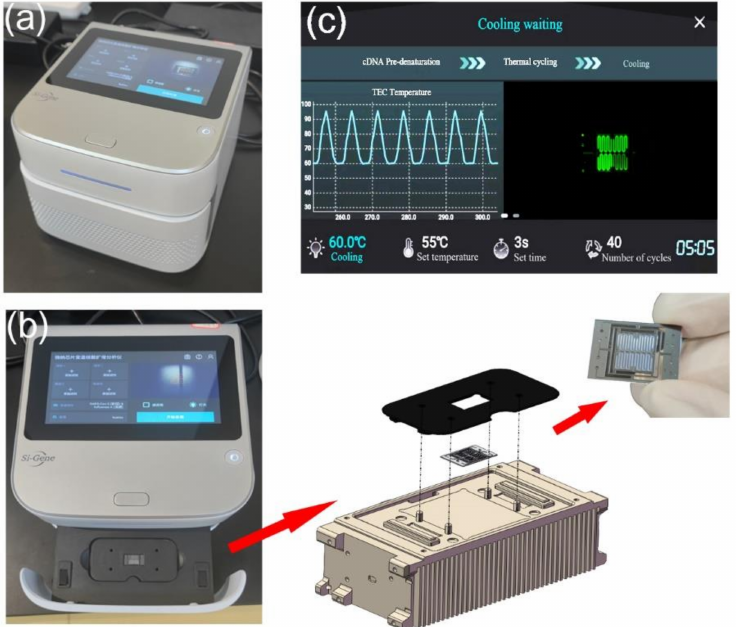
Figure 3. ( a ) Integrated ultrafast PCR detection equipment. ( b ) Slide mechanism for replacing the microfluidic chip. The miniaturized microfluidic chip is fixed on the thermocycling module through a holder. There are four positioning columns on the thermocycling module, which can precisely limit the position of the holder and ensure that the chip is on the best heating area. Two magnets are installed under the holder to ensure the stability of chip fixation through magnetic force. ( c ) The microcomputer can be operated through the touch